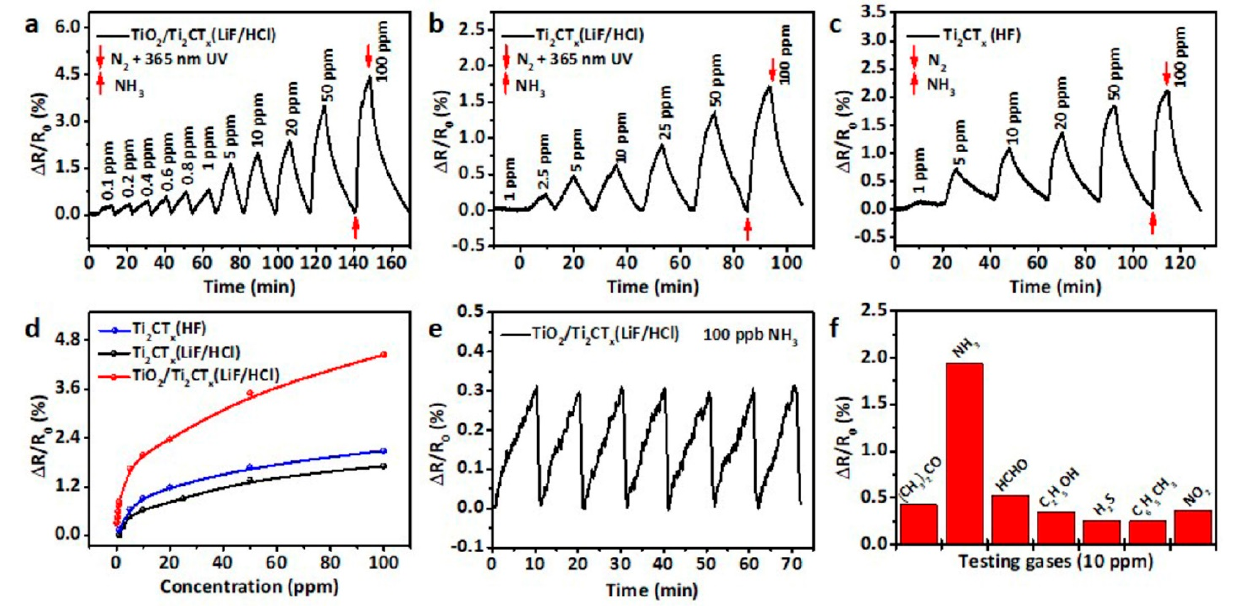
Figure 8. Dynamic response/recovery curves of sensors fabricated from ( a ) TiO 2 /Ti 2 CT x (LiF/HCl) nanosheets, ( b ) Ti 2 CT x (LiF/HCl) nanosheets, and ( c ) Ti 2 CT x (HF) nanosheets in response to NH 3 gas with increasing concentration at RT (e.g., 25 °C). ( d ) Normalized change of resistance of different sensors at various NH 3 concentrations. ( e ) Response/recovery curve for seven successive cycles of exposure to 100 ppb NH 3 gas. ( f ) Response of TiO 2 /Ti 2 CT x (LiF/HCl) nanosheets upon exposure to 10 ppm of (CH 3 ) 2 CO, NH 3 , HCHO, C 2 H 5 OH, H 2 S, C 6 H 5 CH 3 , and NO 2 at RT. Reprinted with permis-